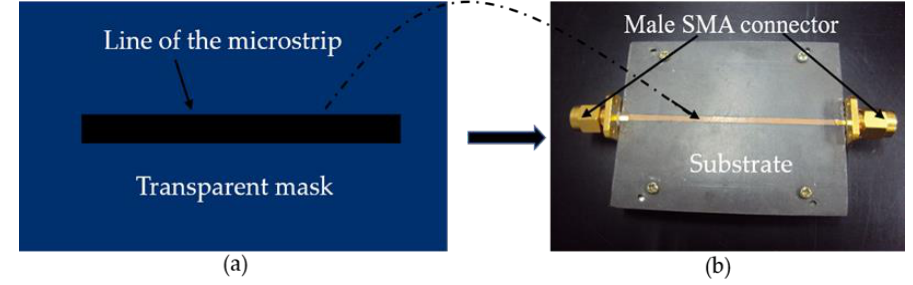
Figure 2. ( a ) Microstrip transmission line printed on a transparent mask. ( b ) The complete microstrip straight line.